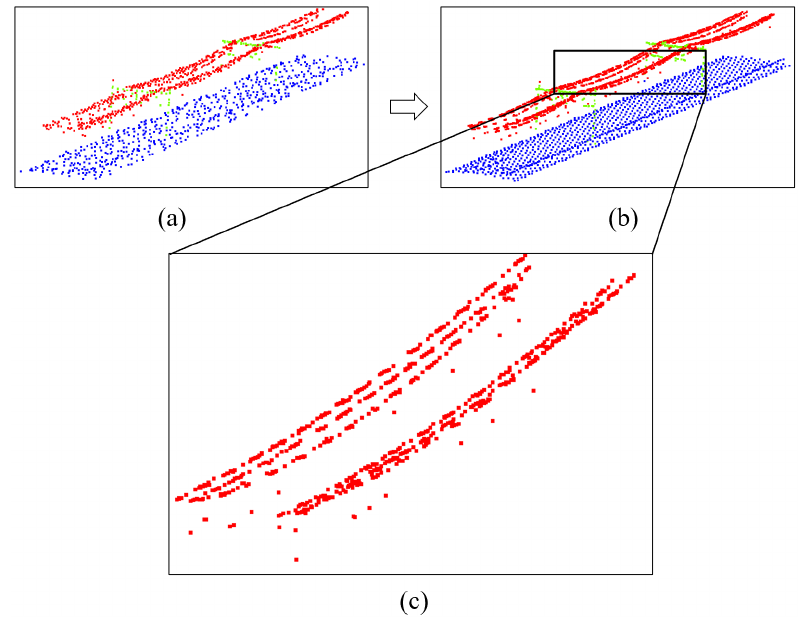
Figure 18. Raw wire reverse mapping and span extraction. ( a ) wire point cloud after segmentation by the proposed model; ( b ) wire segmentation results of the original dataset after reverse mapping; ( c ) span extraction results.